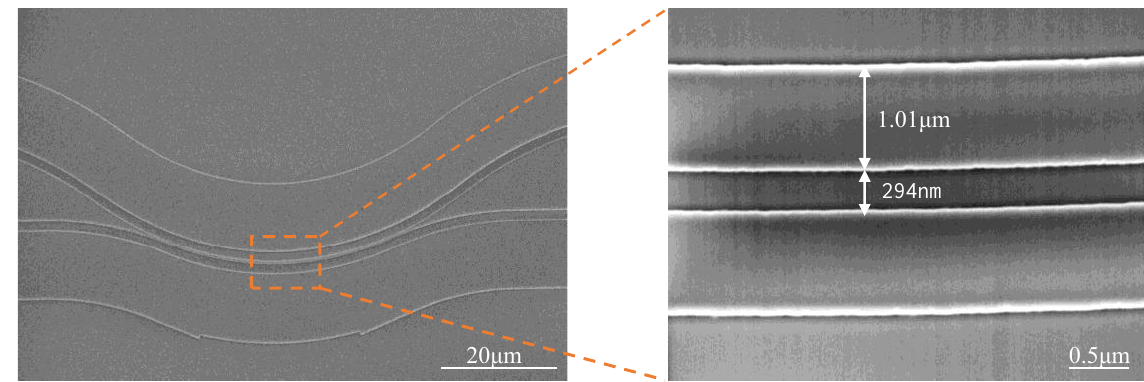
Figure 5. SEM image of the bent DC.